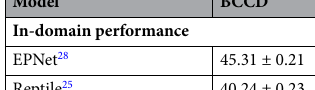
Table 4. Test accuracy results from in-domain training on HEp-2 and testing on BCCD.